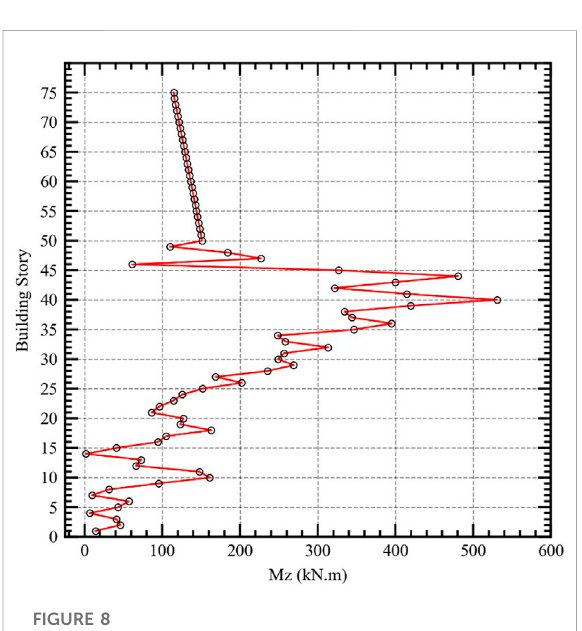
FIGURE 8 Torsional moment (Mz) around the building ’ s center.